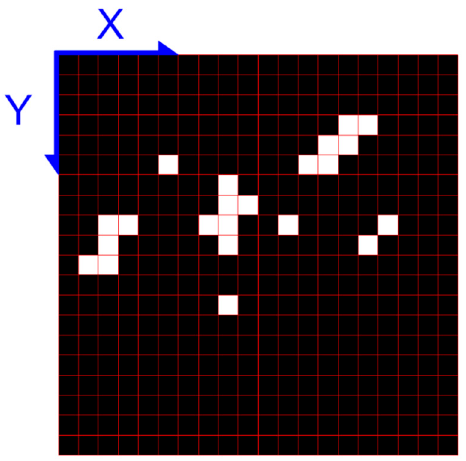
Figure 2. Raster map model. Black fields are obstacle-free, white ones contain obstacles.